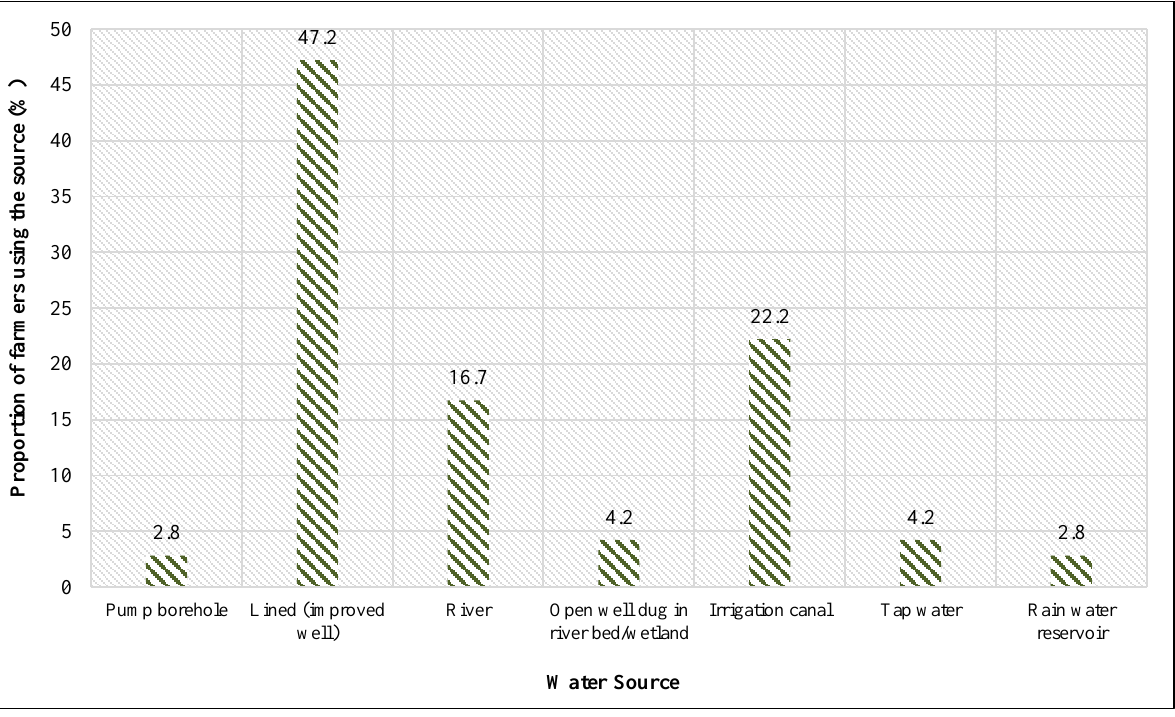
Figure 3. Source of water at the community